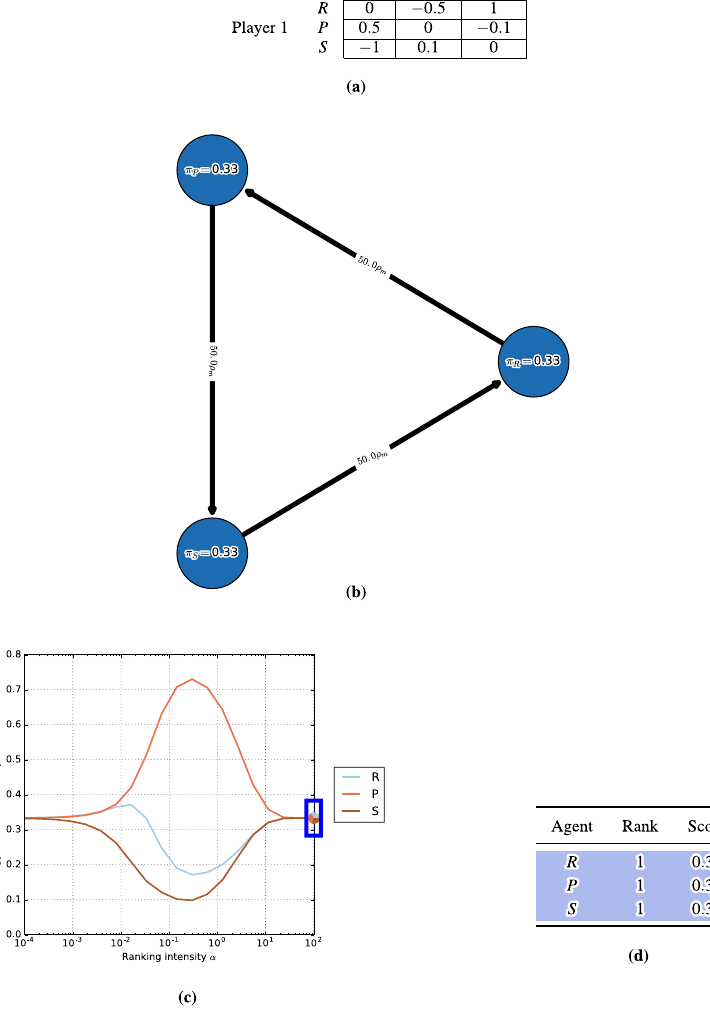
Figure 7. Biased Rock-Paper-Scissors game. ( a ) Payoff matrix. ( b ) Discrete-time dynamics. ( c ) Ranking- intensity sweep. ( d ) α -Rank